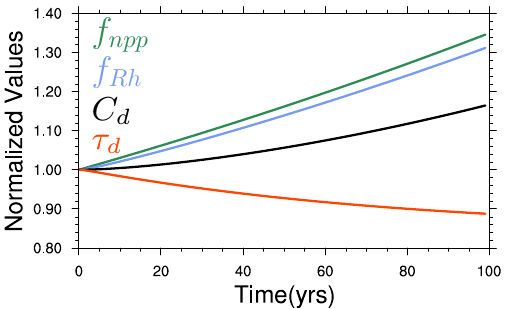
Figure 12. Box model experiment to illustrate the phenomenon of “false priming”. Results are from a simplified system: three pools with fixed turnover times of 1, 10, and 100years, arranged in a se- quential cascade and fixed carbon use efficiency of 0.3, 0.3, and 0.0 (Eq. 16). Here, the system is perturbed from steady-state by an exponential NPP increase, f NPP , of 0.3%yr − 1 . Because flux- weighted turnover in such a system is faster than mass-weighted turnover, f Rh responds faster than C d , and therefore aggregated τ d drops in response to increased inputs even though the carbon in- creases and the individual turnover times of each pool remain the